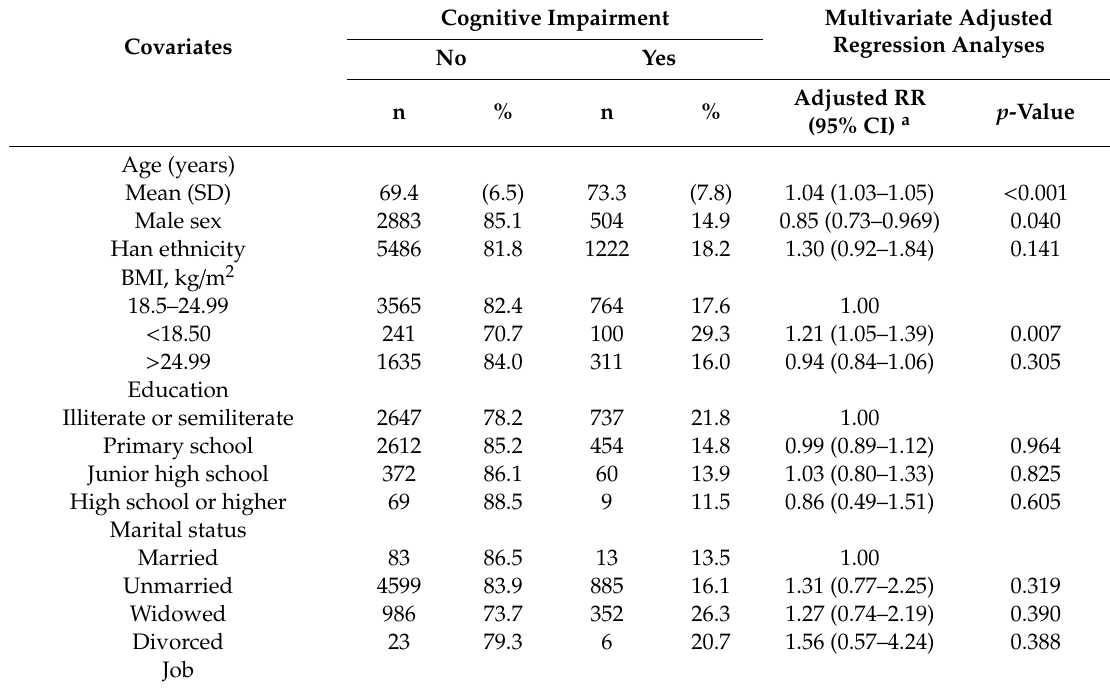
Table 2. Adjusted relative risks (RRs) for the association between passive smoking exposure and cognitive impairment (ZJMPHS Program, Zhejiang,